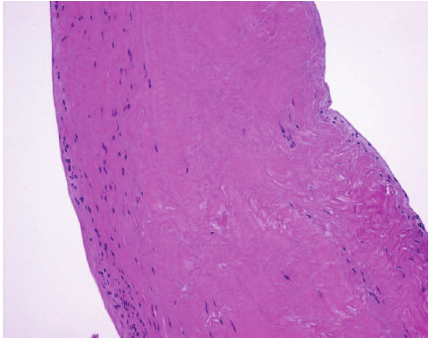
Figure 8: Histopathology: elastic fiber stain, magnification